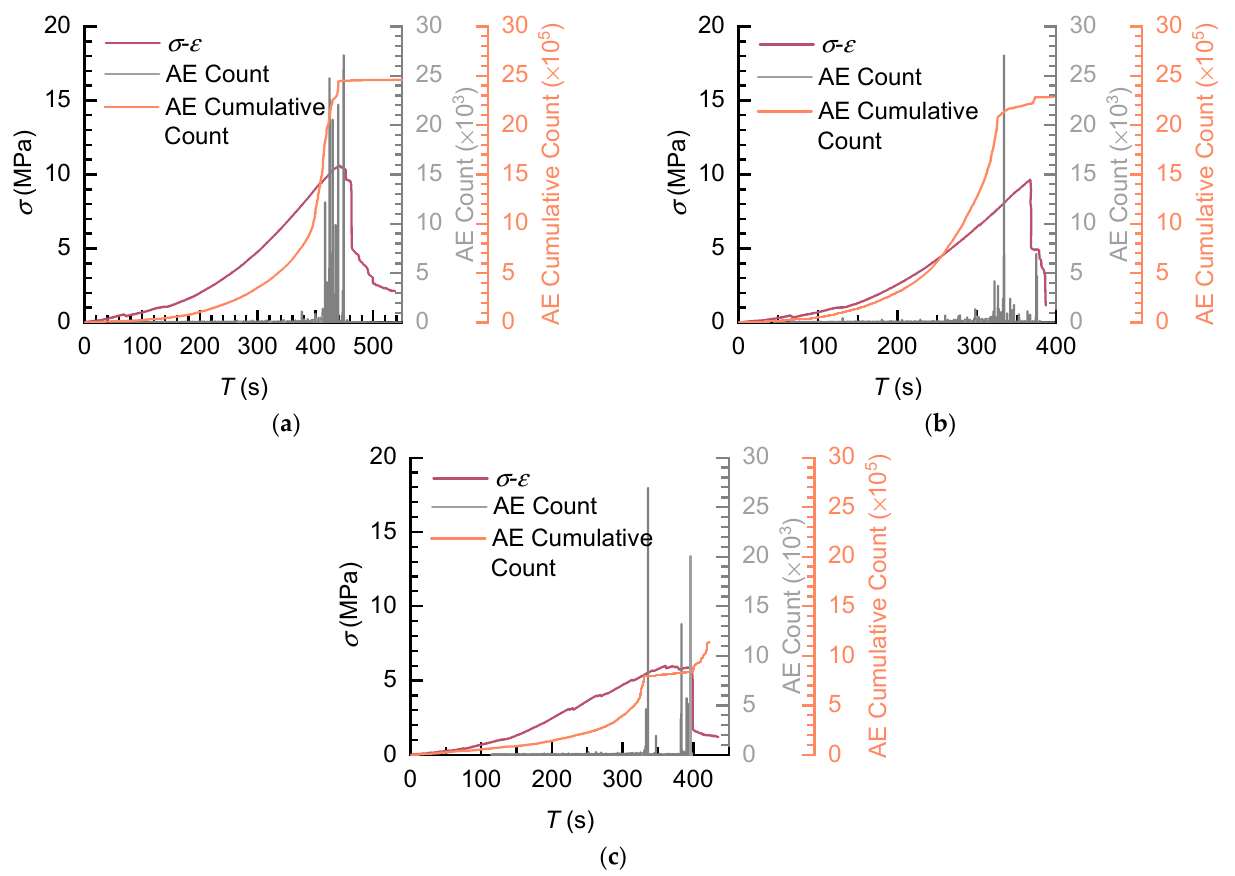
Figure 12. Acoustic emission characteristic curve of coal samples with dry-wet cycles, they should be listed as: ( a ) N = 1; ( b ) N = 2; ( c ) N = 3.